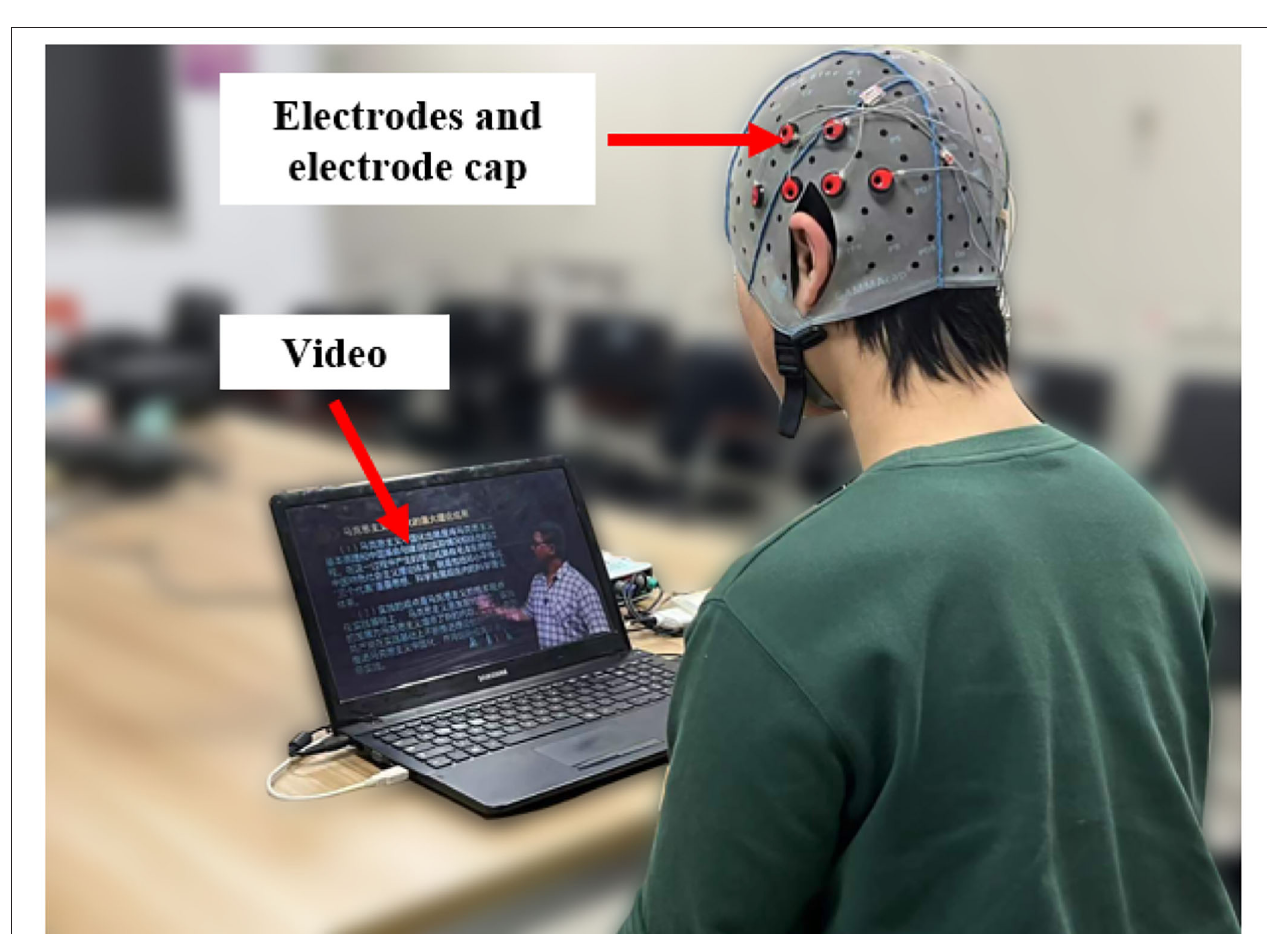
FIGURE 2 | Schematic diagram of the experimental